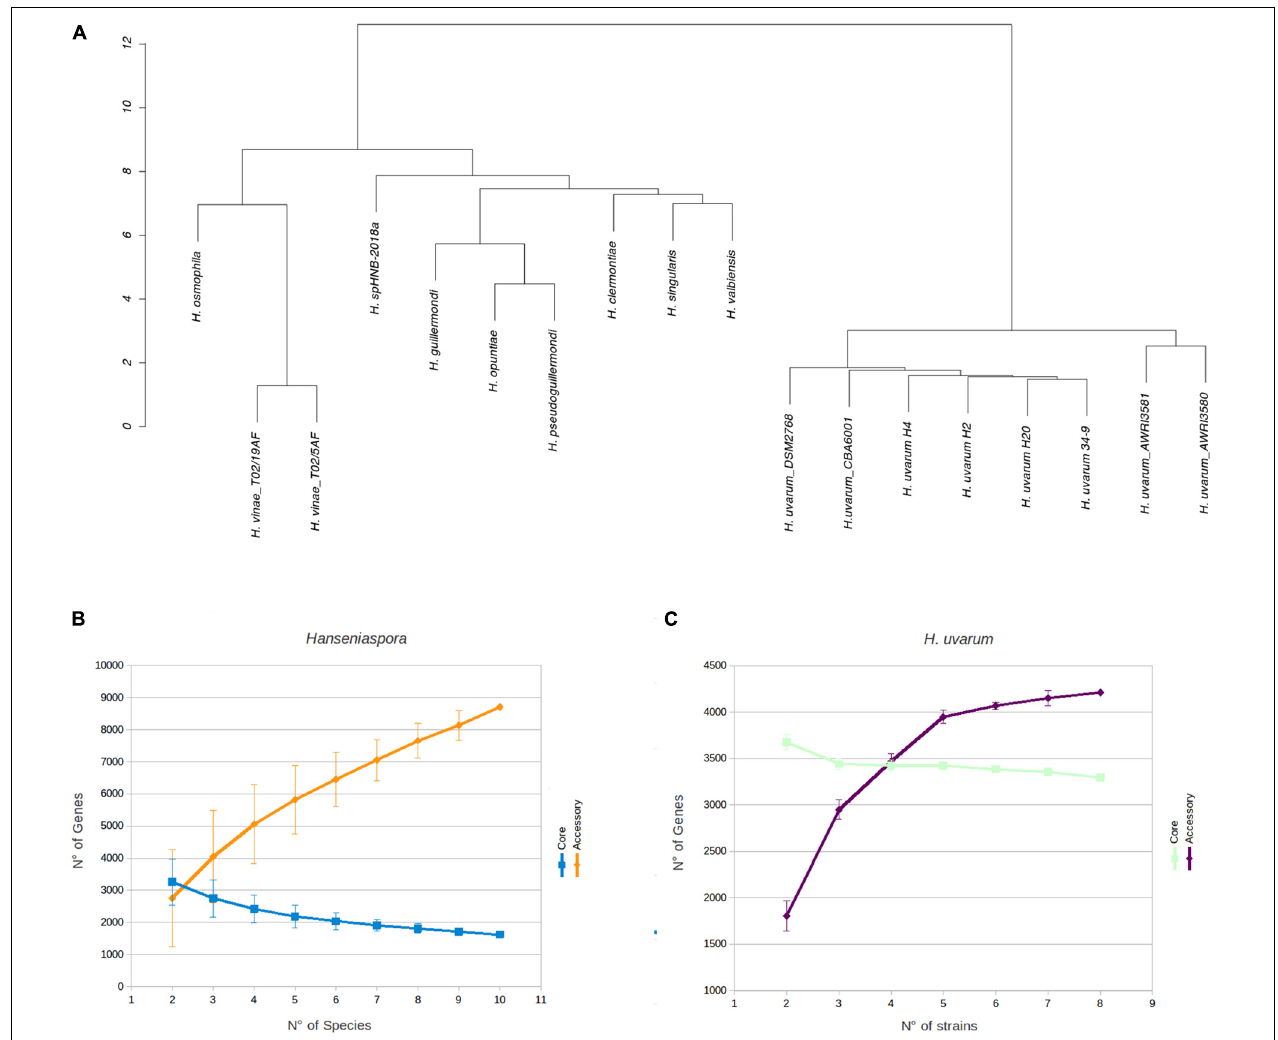
FIGURE 2 | Phenetic clustering of Hanseniaspora and rarefaction analyses. (A) Hierarchical clustering of Hanseniaspora based on genomic identity. Pairwise levels of genomic identity were established by pairwise genome alignment, after masking dimorphic sites in each genome. Clustering was performed based on Euclidean distances of identity profiles. (B) Estimation of completeness of core and accessory genomes by rarefaction analyses at the genus level. Core and accessory genome sizes were calculated for all possible combinations of Hanseniaspora genomes. One representative species was selected for each genus included in the analyses (see section Materials and Methods). (C) Estimation of completeness of core and accessory genomes by rarefaction analyses for H. uvarum . Core and accessory genome sizes were calculated on each possible randomly resampled combinations of H. uvarum